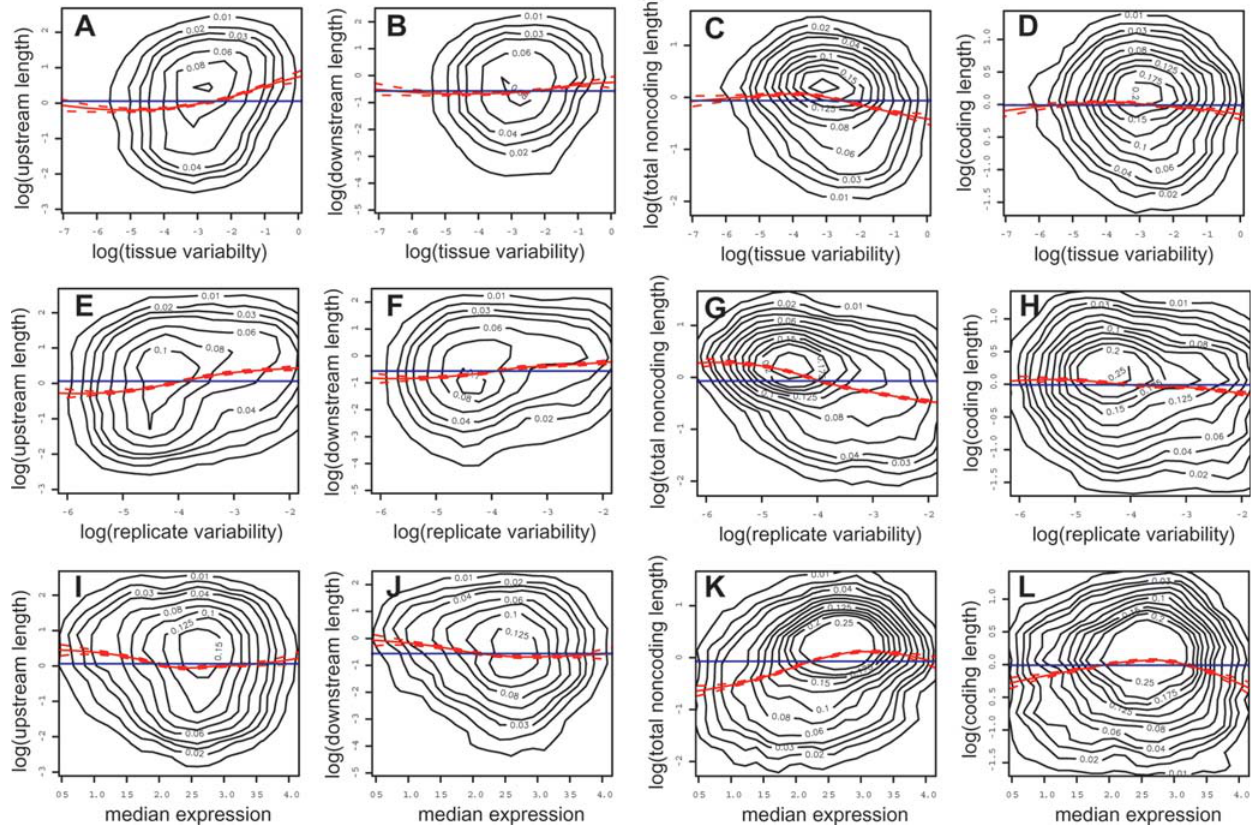
Figure 4. Upstream and gene coding or noncoding sequence lengths have opposite relationships with mRNA expression. Relationships between the (log) lengths (in kb) of the sequences associated with a gene and its diagnostic expression measures for variability (tissue variability), noise (replicate variability) and level (median).